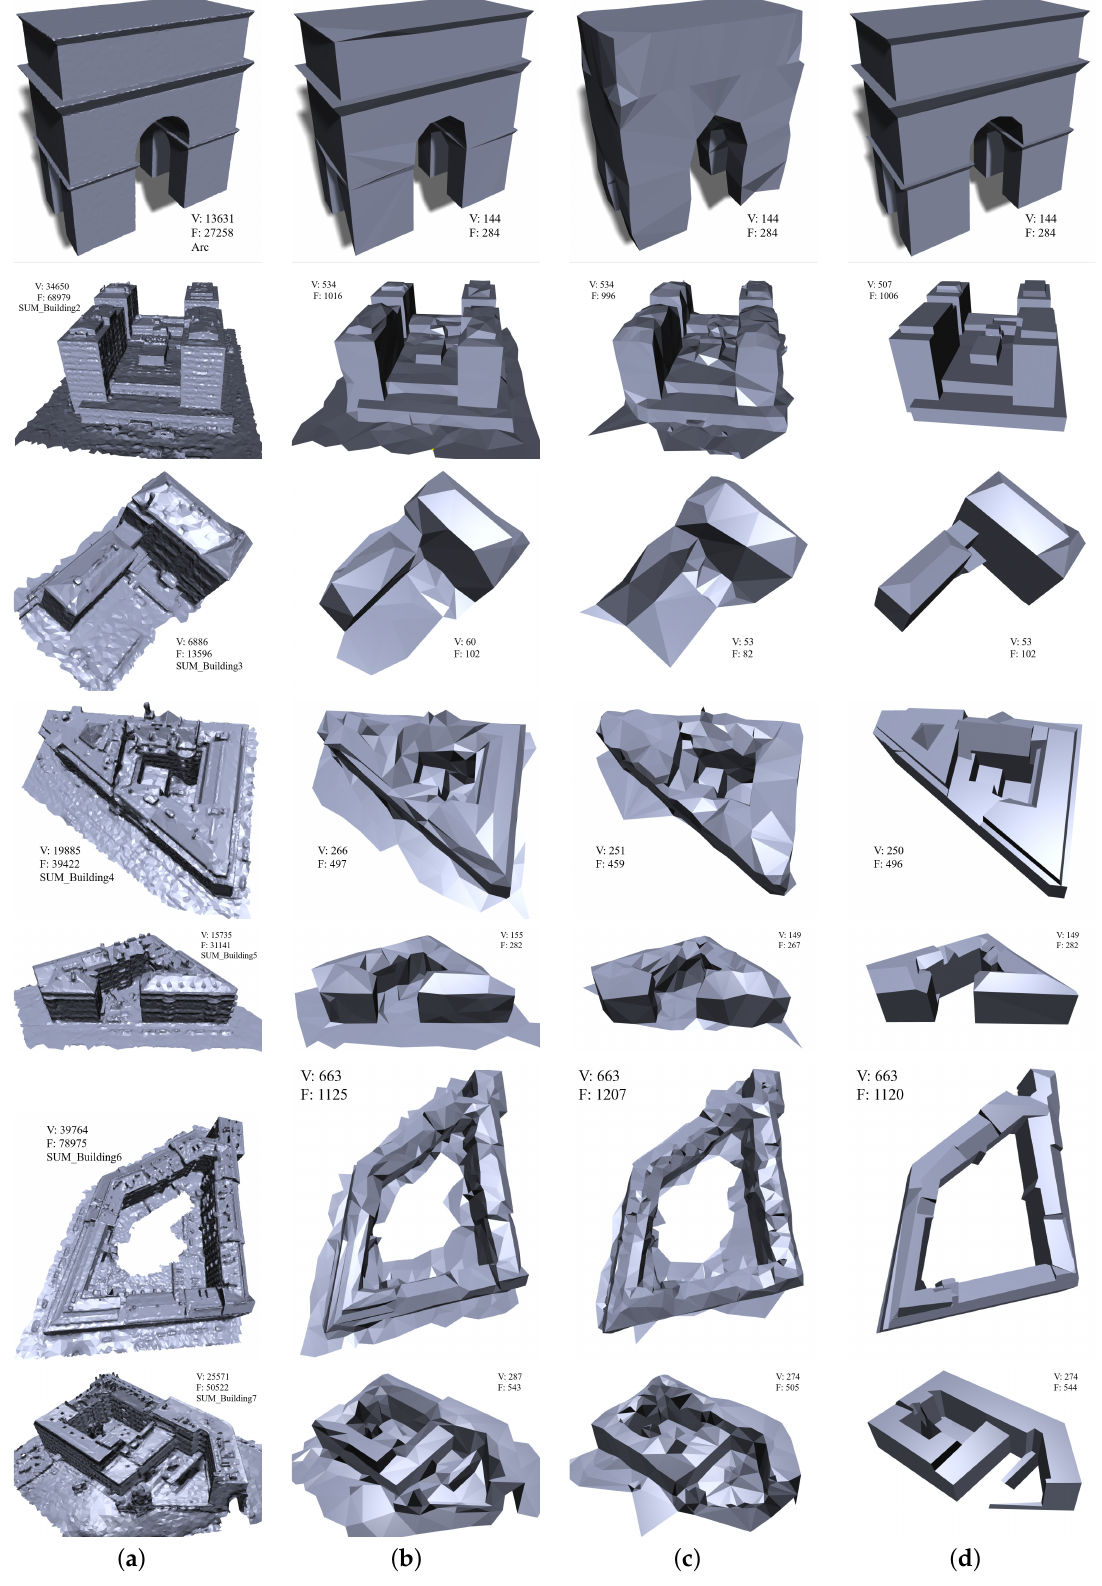
Figure 11. Visual comparison of our method with other simplified techniques for the same number of vertices or faces: ( a ) Original, ( b ) QEM [17], ( c ) ACVD [21], and ( d )